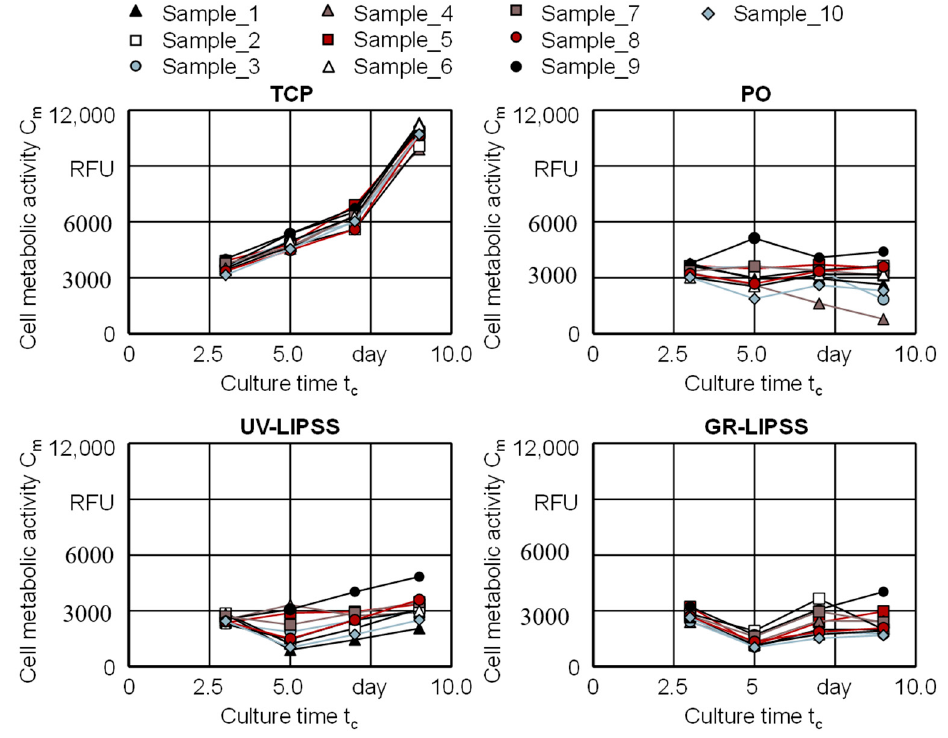
Figure 5. Cell metabolic activity C m for TCP, PO, UV-LIPSS, and GR-LIPSS on each sample